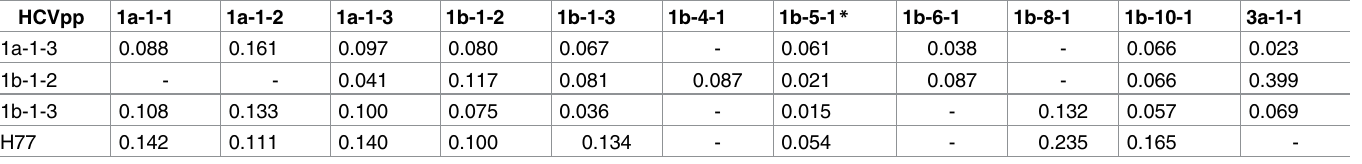
Table 3. IC 50 values (mg/ml) of neutralisation curves in Fig 3 and Fig 4 for each VF-Fab. HCVpp